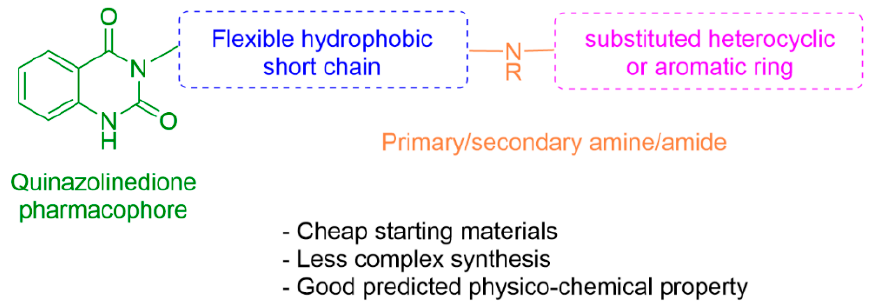
Figure 2. Medicinal chemistry rationale to probe the SARs around the quinazolinedione Figure 2 . Medicinal chemistry rationale to probe the SARs around the quinazolinedione core .